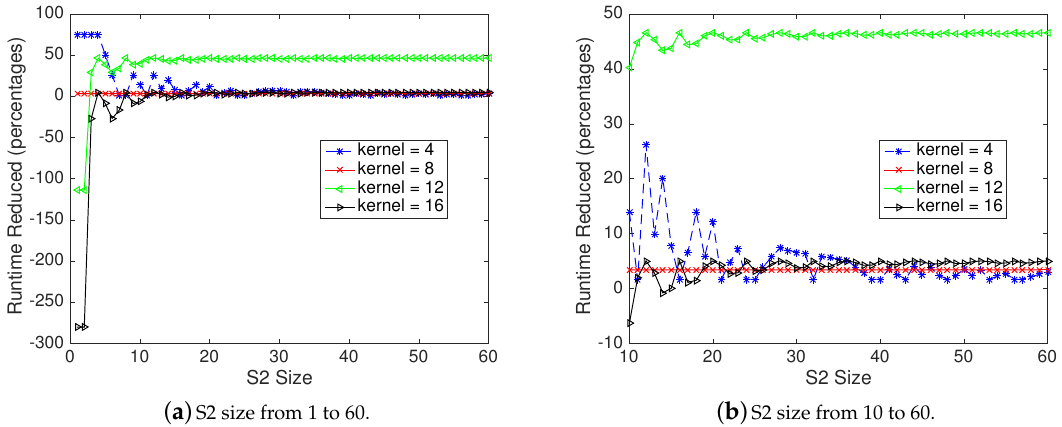
Figure 6. Percentage of SAFA runtime reduction compared to CoRe16. Note that when kernel size = 12, CoRe 16 does not work at full load due to the adder tree mechanism to produce an output pixel. For a fair comparison, we exclude the performance gain when kernel = 12 compared with CoRe16. However, we still achieve better performance. As shown in Figure 6b, the average runtime reduction compared with CoRe16 is 5.7% under different kernel sizes except for kernel =12 (since it is not suited for